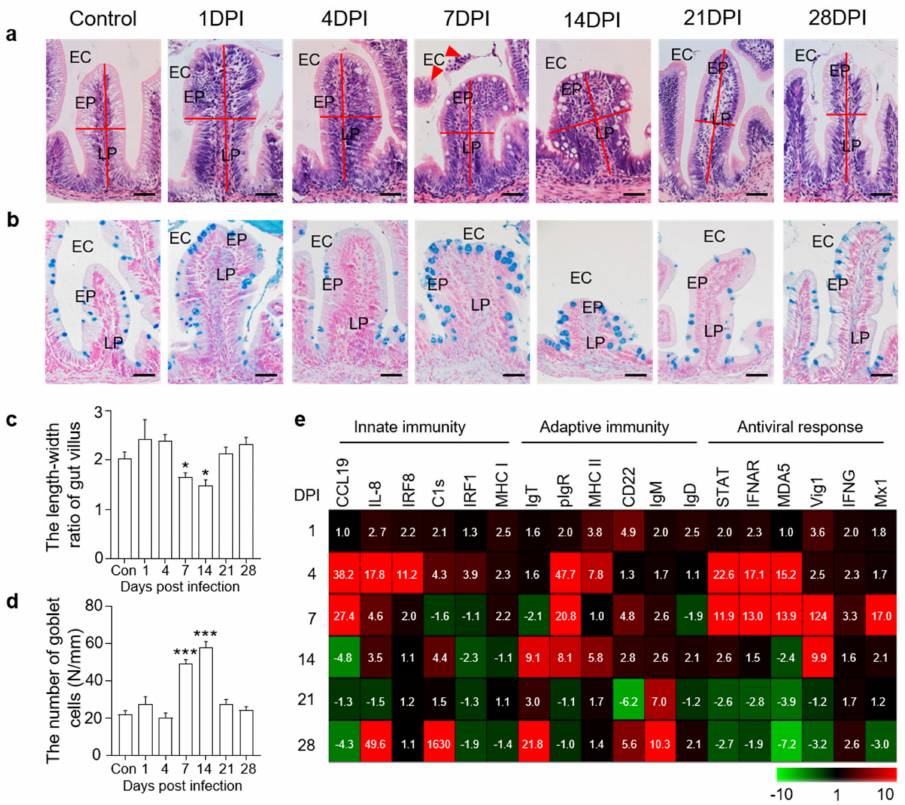
Figure 2. Histopathological changes and immune gene expressions in the trout gut after IHNV infection. ( a ) H&E staining of the gut from control and experimental fish infected with IHNV after 1, 4, 7, 14, 21, and 28 days ( n = 6 fish per group). EC, enteric cavity; EP, epidermis; LP, lamina propria. Scale bars, 50 µ m. The red line indicates the length or width of gut villus. The red triangle indicates shedding cells. ( b ) AB staining of the gut from control fish and experimental fish infected with IHNV after 1, 4, 7, 14, 21, and 28 days ( n = 6 fish per group). EC, enteric cavity; EP, epidermis; LP, lamina propria. Scale bars, 50 µ m. ( c ) The length − width ratio of gut villus of control and infected fish ( n = 6 fish per group). ( d ) The number of goblet cells of gut villus from control and infected fish ( n = 6 fish per group). ( e ) Heat maps illustrate results from quantitative real − time PCR of transcripts for selected immune markers from gut of IHNV − infected versus control fish measured at 1, 4, 7, 14, 21, and 28 DPI ( n = 6 fish per group). Data are expressed as mean fold increase in expression. Color value: fold change. Statistical differences were evaluated by unpaired Student’s t − test. Data in ( c , d ) are representative of six independent experiments (mean ± SEM). (*) p < 0.05, (***) p <